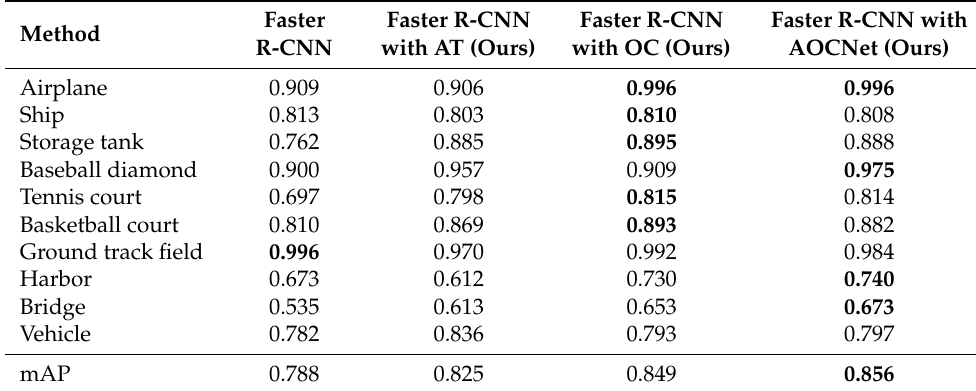
Table 7. The ablation experiment of the designed